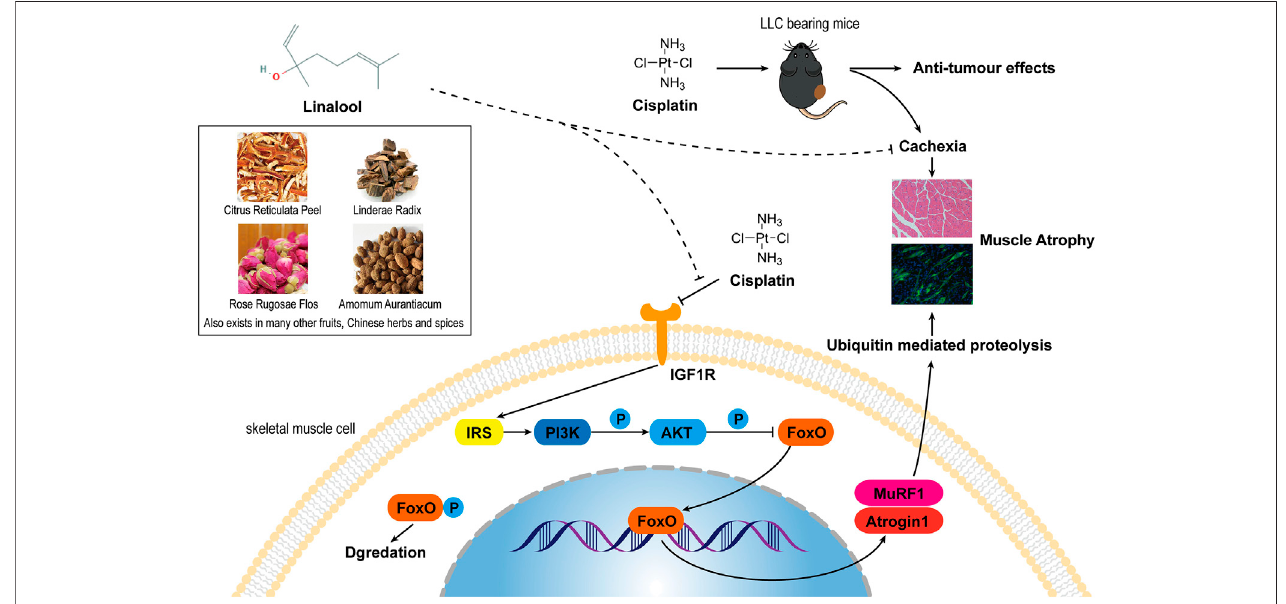
FIGURE 7 | A summary of the effect and mechanism of the anti-DDP-induced muscle atrophy of LIN. LIN comes from a variety of Chinese herbal medicines, fruits and spices, and is widely distributed in nature. LIN can improve the cachexia symptoms of DDP-treated tumour-bearing mice and reduce muscle atrophy without affecting the anti-tumor ef fi cacy of DDP. The mechanism is that LIN can down-regulate the expression of Atrogin1 and MuRF1 through the IGF-1/Akt/FoxO pathway to alleviate muscle atrophy.